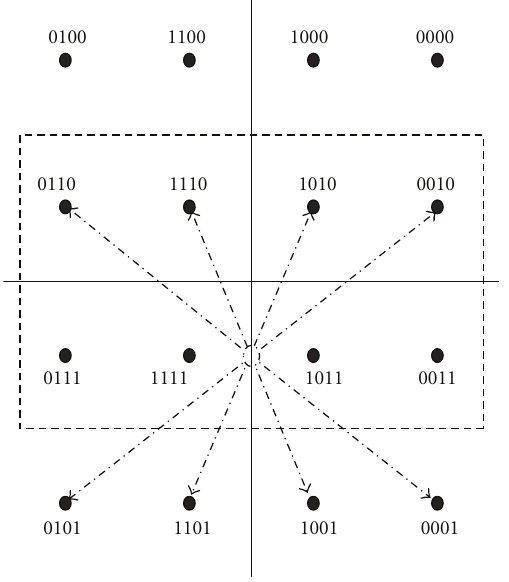
Figure 4: 16-ary QAM modulation with non-Gray coding.